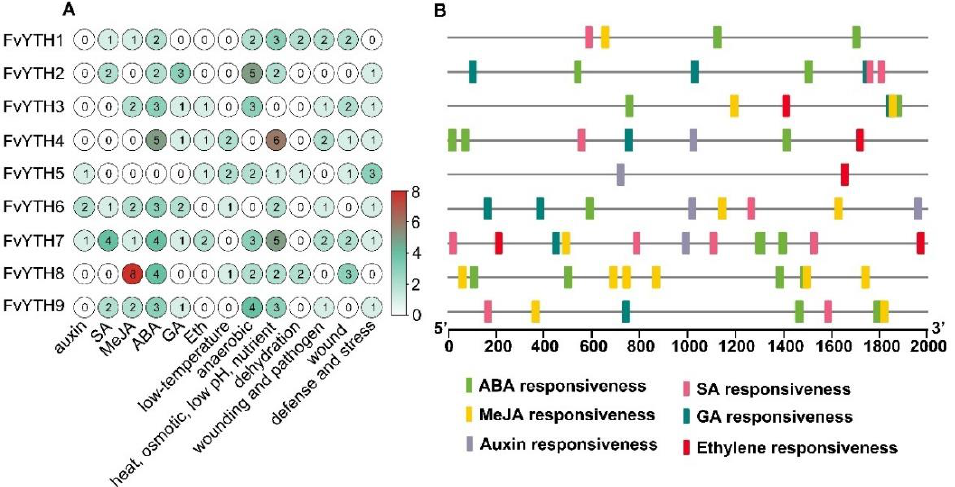
Figure 5. The cis- elements analysis of promoters in FvYTH genes. The 2 kb DNA fragment upstream of the initiation codon of each FvYTH gene was analyzed using the online software PlantCARE. ( A ) The number of cis- elements related to hormones and stress in each FvYTH promoter. ( B ) The distribution of hormone-response elements in the FvYTH gene promoters.